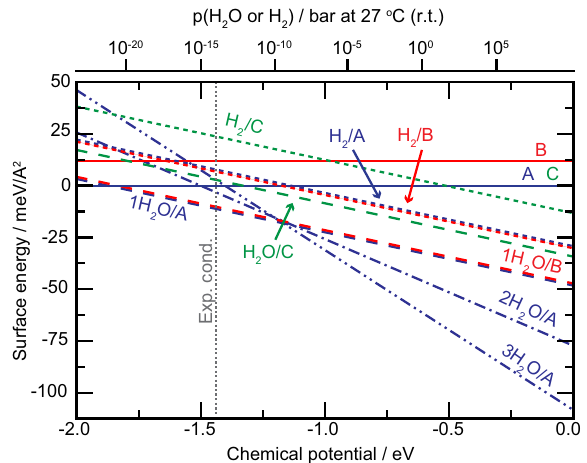
Fig. 5 Phase diagram for the bare, water, and hydrogen covered surface models. The surface stability for bare, water and hydrogen covered A (blue), B (red), and C (green) surface models are displayed. All surface models are considered for the case of a bare surface (line), one adsorbed water molecule (dashed line) and one adsorbed hydrogen molecule (dotted line). Additionally, Model A is considered with two and three water molecules (dash-dotted line and dash-dot-dotted line, respectively). The energies are reported with respect to the bare surface energy of Model A. The chemical potential corresponding to the experimental conditions during surface analysis ( − 1.44 eV) is indicated by a vertical